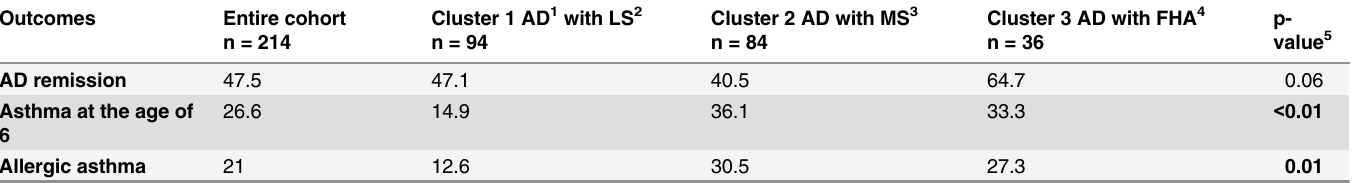
Table 3. Parameters at the end of the follow-up (6